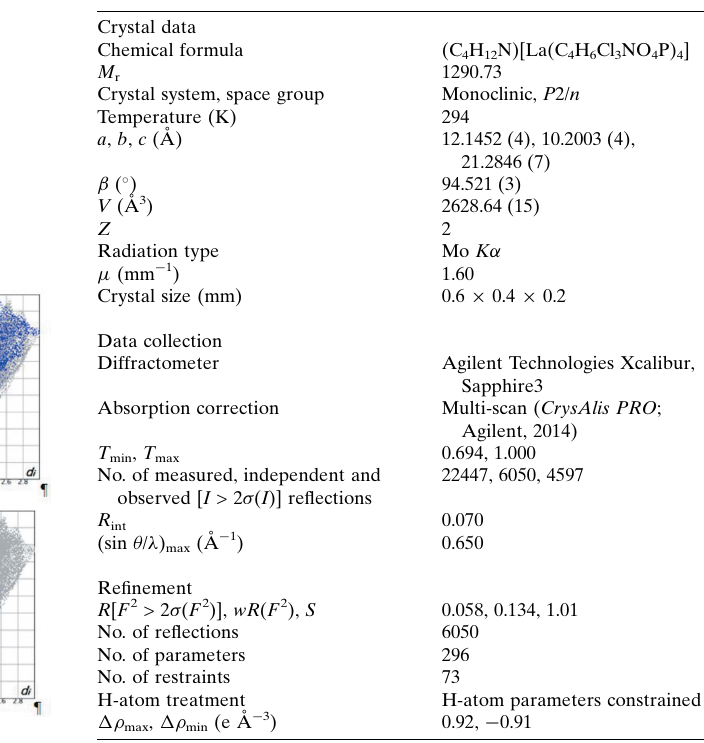
Table 2 Experimental details.